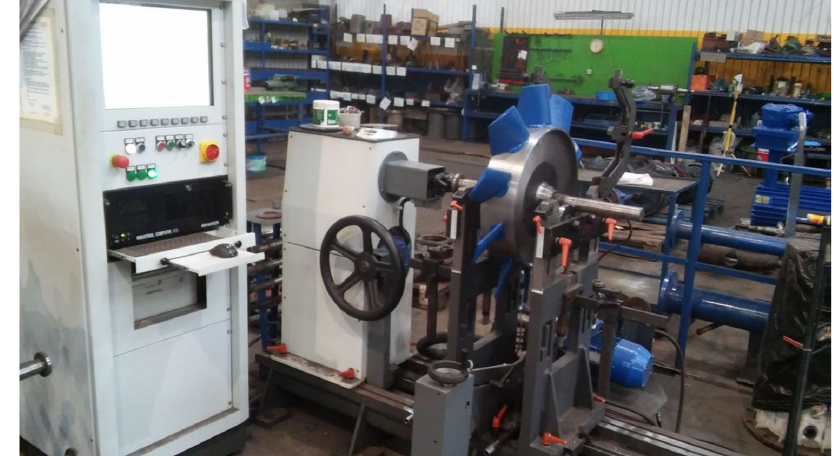
Figure 17. Determination of the correct blade angle.